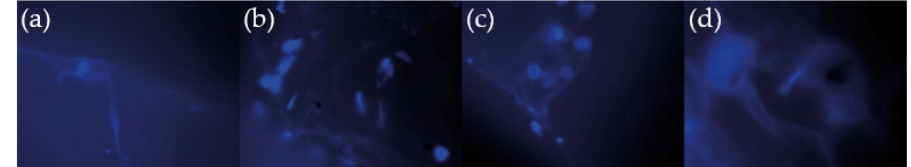
Figure 14. Epifluorescence micrographs of DAPI-stained MC3T3 cells seeded on ( a ) PCL; ( b ) PCL + Hydrogel; ( c ) PCL/NaCl + Hydrogel; and ( d ) PCL/nHA/NaCl + Hydrogel.